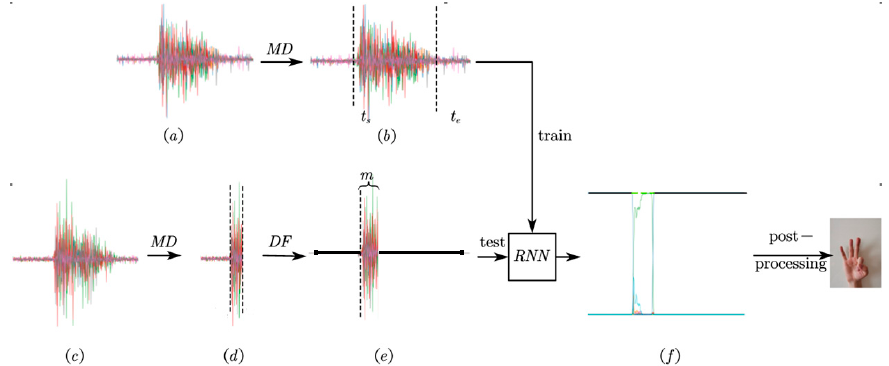
Figure 6. Flow diagram of the training stage. MD: motion detection. DF: data filling. ( a ) Training data. ( b ) Modify label of sample. ( c ) Test data. ( d ) Data after motion detection. ( e ) Prepare input data by DF. ( f ) The output of the RNN model.